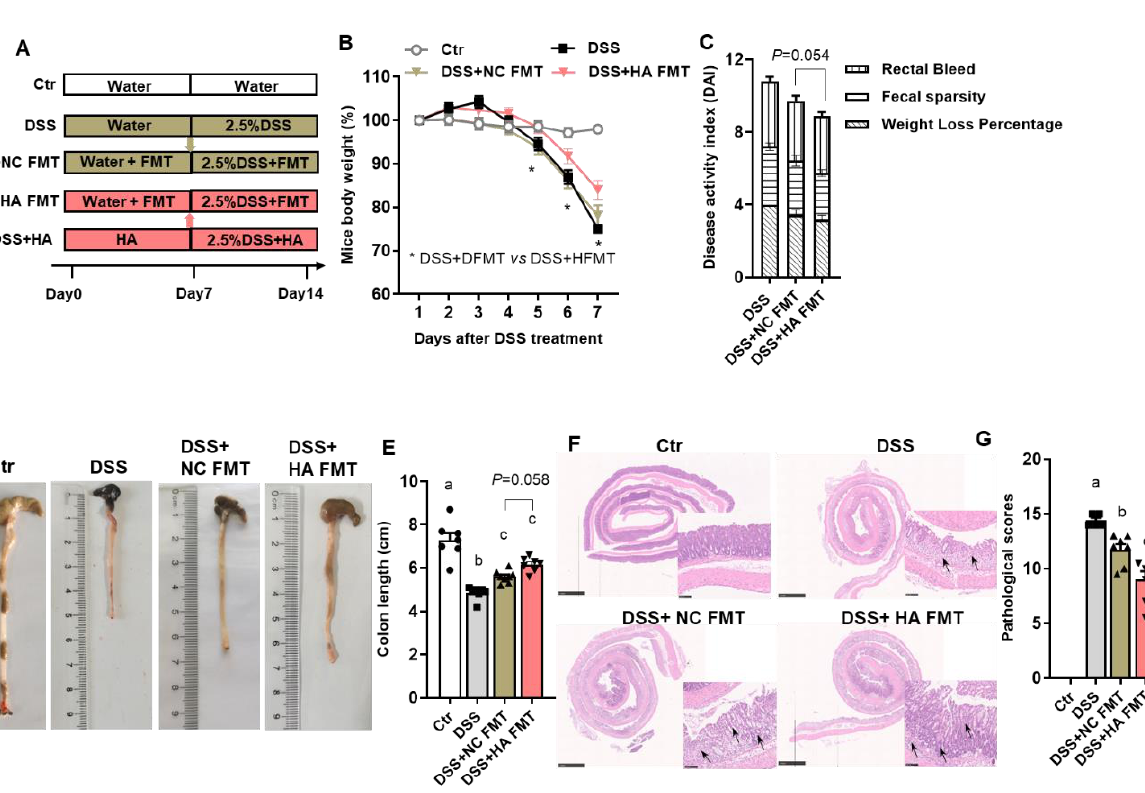
Figure 4. Microbiota Transplants (FMT) from colitis mice treated with HA ameliorate colitis. ( A ) Experimental design. ( B ) Percentage change in body weight after DSS treatment. ( C ) Disease activity index on day 7. ( D , E ) Representative images and length of the colon. ( F , G ) Representative image of H&E staining of colon and pathological score. The small panels (20×) were enlarged from the large panels (2.5×). Data are expressed as mean ± SE, n = 8 – 10, and significant differences ( p < 0.05) are denoted by a,b,c.